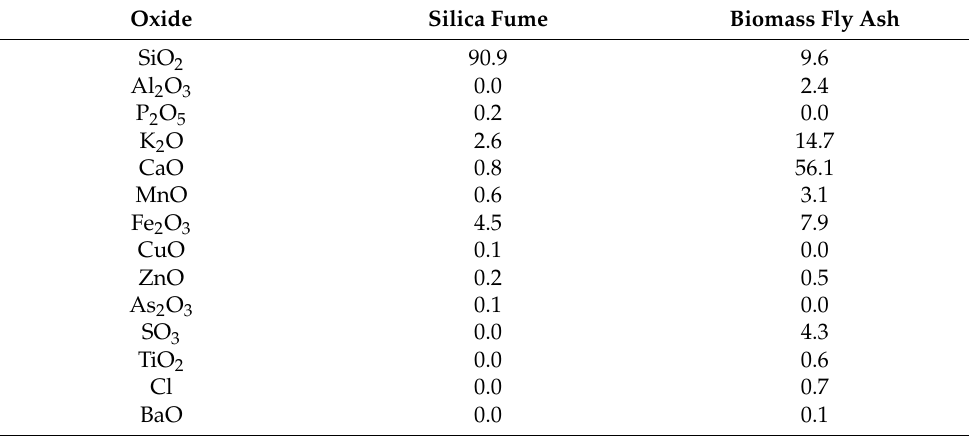
Table 1. Chemical Oxide Composition of Biomass Fly Ash and Silica